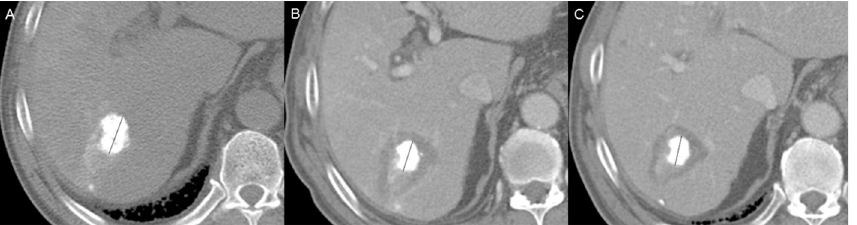
Fig 4. 46 year-old man with hepatocellular carcinoma. (a) After transcatheter arterial chemoembolization (TACE), concentrated iodized oil delineates tumor on post-TACE CT (longitudinal tumor diameter, 27.8 mm). (b) Following completion of sequential radiofrequency (RF) ablation, low-attenuation ablation zone encircles index tumor. Tumor size diminished on post-ablation CT (decline in longitudinal tumor diameter: 27.8 mm ! 20.7mm; 25.5% post- ablative reduction rate) for post-ablative volume reduction rate of 60.1%. (c) Stability of tumor confirmed by follow-up CT scan 1 month after RF ablation (20.7 mm ! 20.4